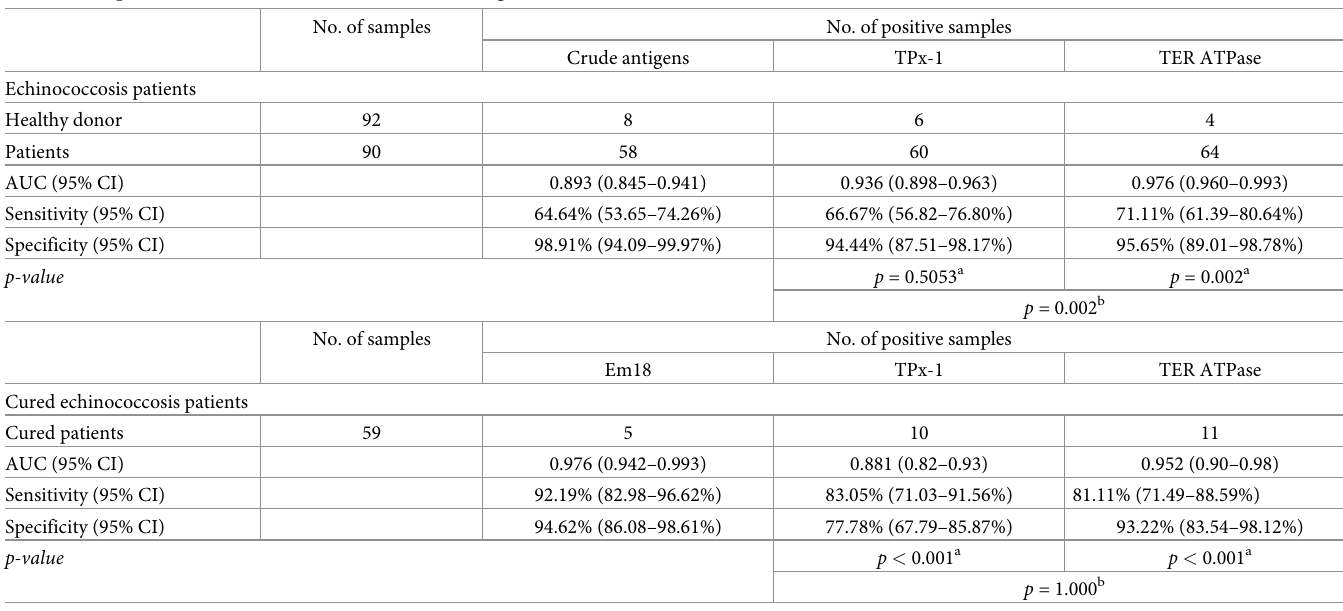
Table 4. The performance of TPx-1 and TER ATPase in diagnosis of human echinococcosis. No. of